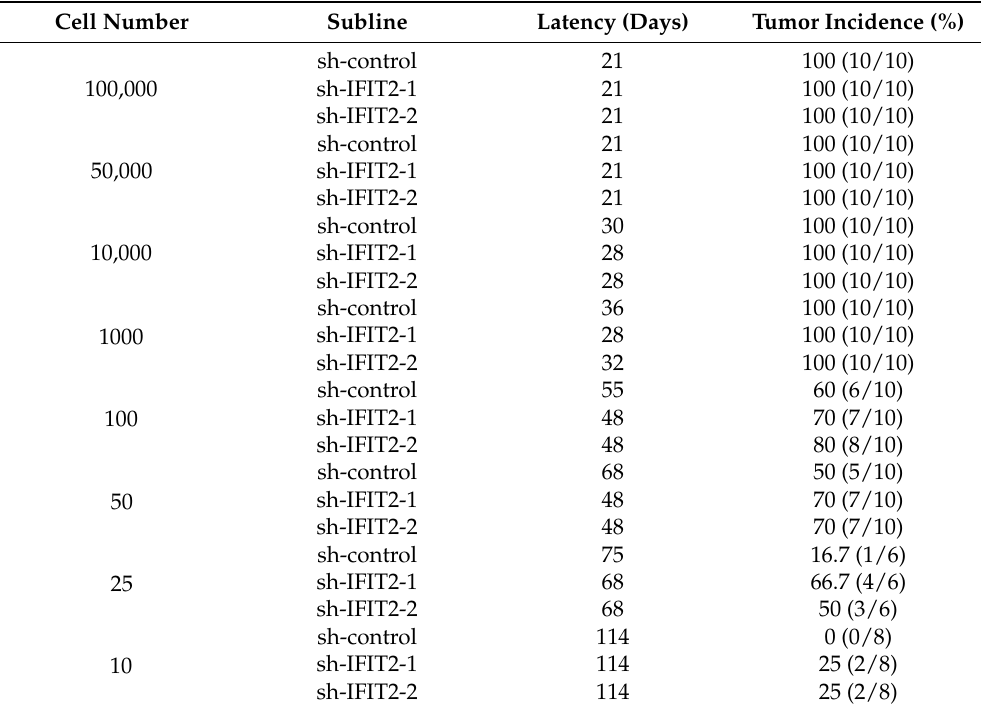
Table 1. In vivo tumorigenicity of IFIT2-depleted oral cancer